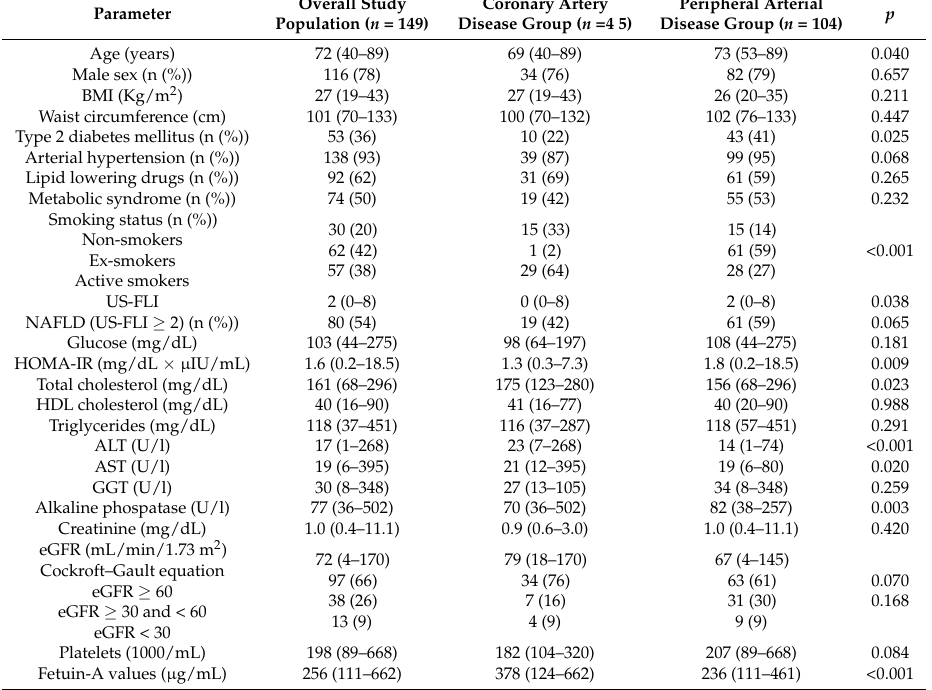
Table 1. Clinical features of study population and comparison of coronary artery disease vs. peripheral arterial disease